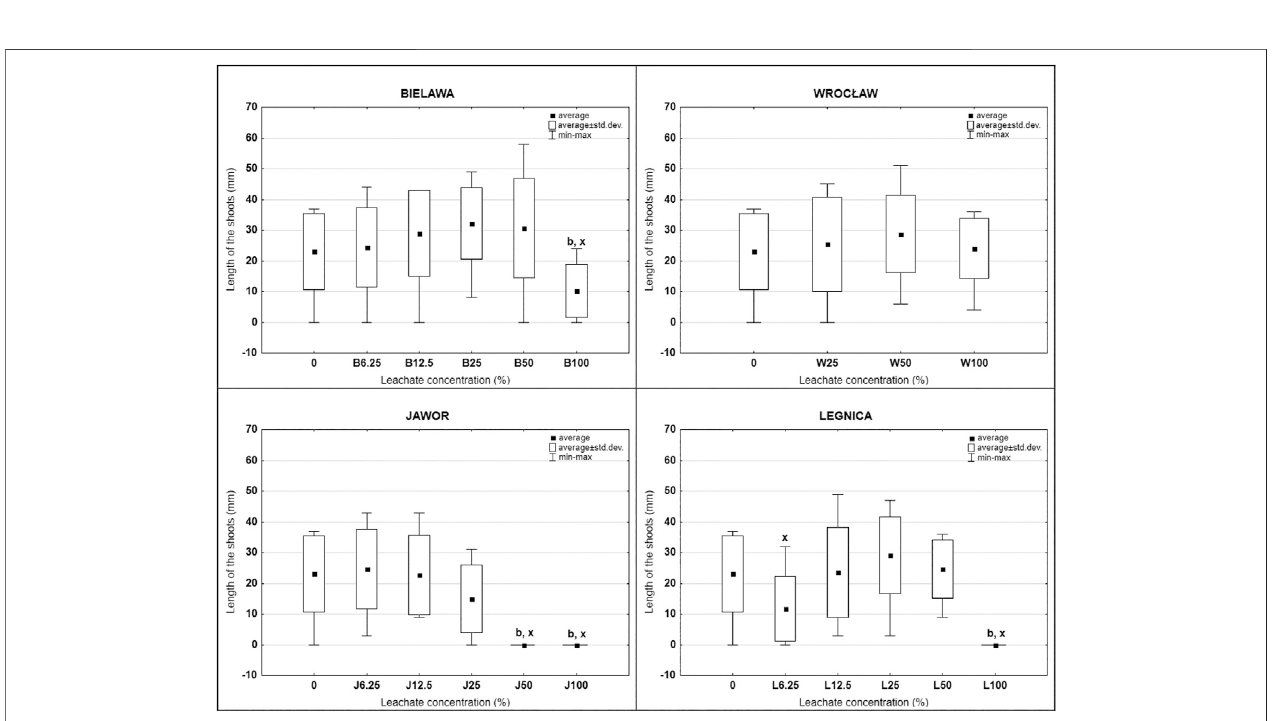
FIGURE 6 | Characteristic values (mean, standard deviation, minimum, maximum) for the results of shoot length measurements-series 12.2019.